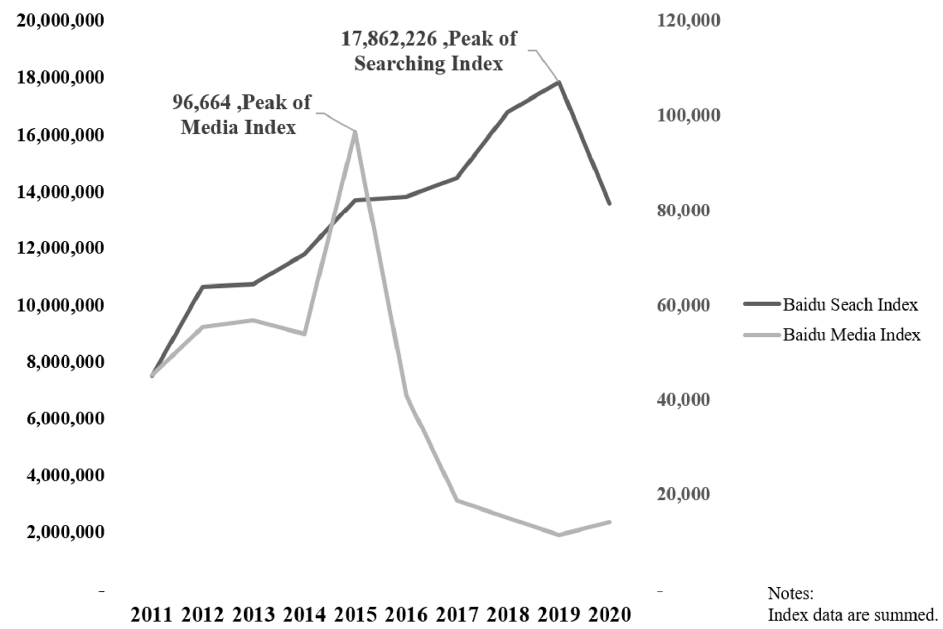
Figure 2. Yearly distribution of the two indices over ten years.